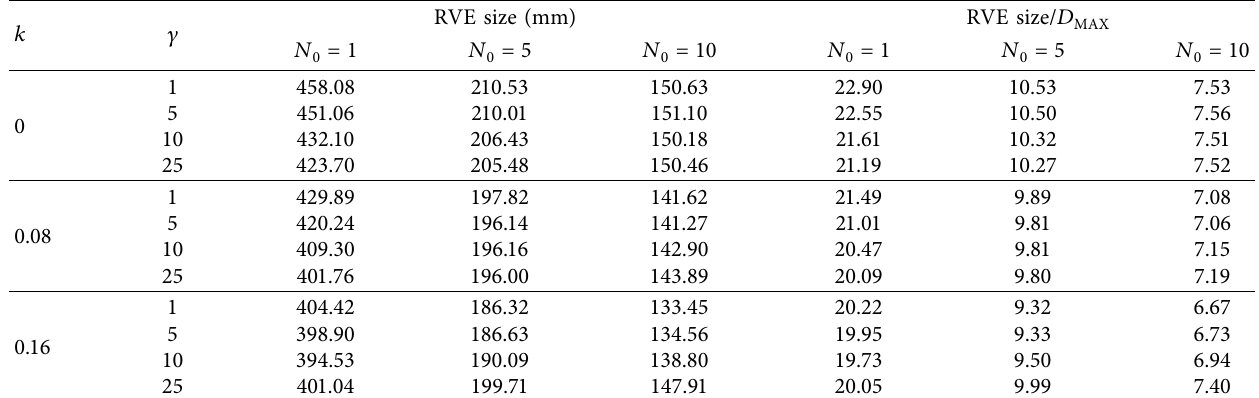
Table 3: RVE size estimation for diferent number of numerical